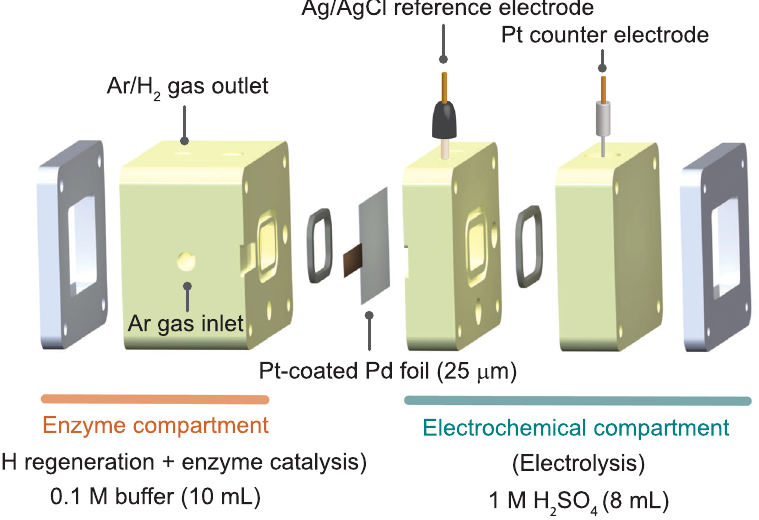
Fig. 2 | 3D-printed reactor design of the BioPMR. The 2-compartment cell con- tains an electrochemical compartment fi lled with 1M H 2 SO 4 and an enzyme com- partment fi lled with buffer solution. The electrochemical compartment contains a